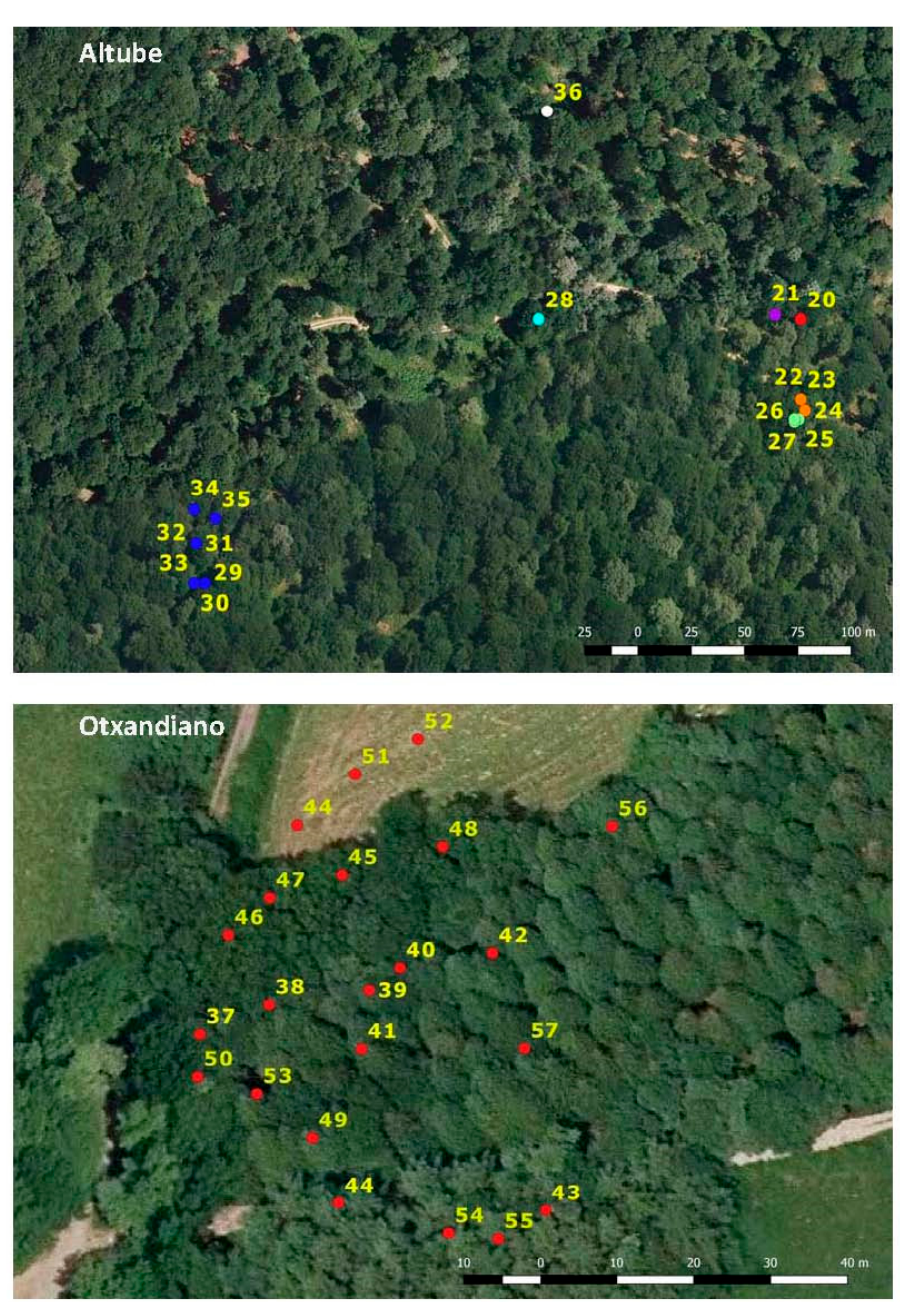
Figure 7. Spatial distribution of the infected trees and Armillaria spp. genotypes. Numbers correspond to Armillaria spp. isolates. Same genotype is marked with the same color. From top to bottom, stand located in Amunategi, stand located in Altube, and stand located in Otxandiano.